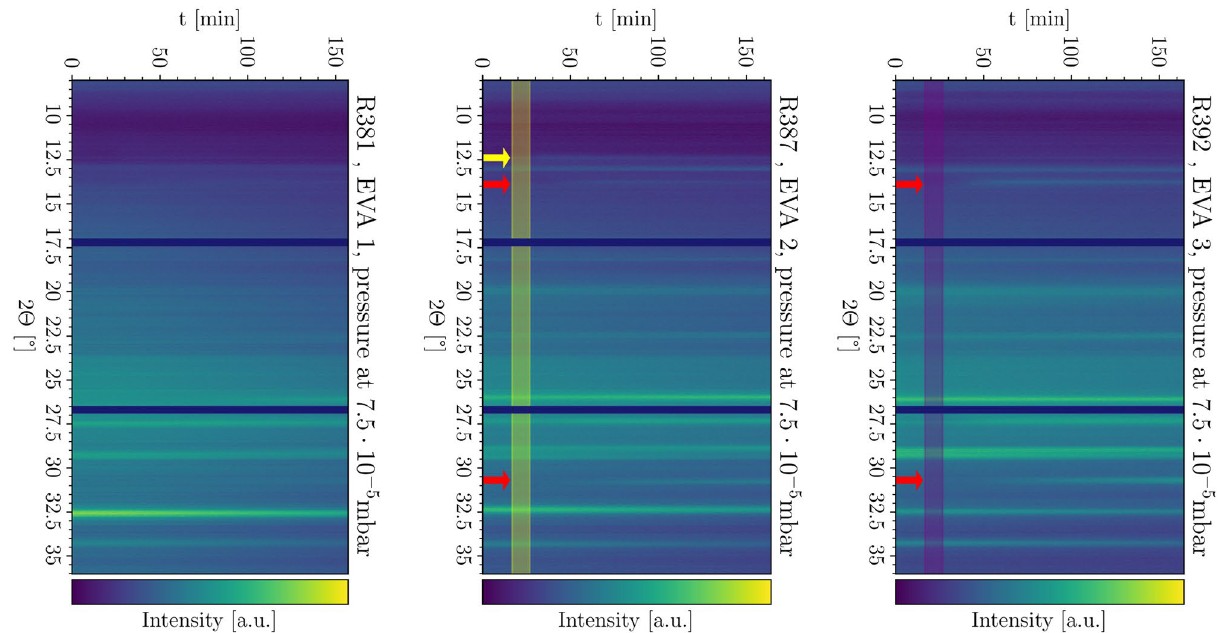
Figure 3. In situ XRD scans of Eva 1 (left), Eva 2 (middle) and Eva 3 (right). The yellow arrow marks the significant PbI 2 peak while the red arrows indicate the significant MAPI peaks 16,17 . Pre-evaporation intervals are marked by colored rectangles (yellow: PbI 2 pre-evaporation, purple: MAI